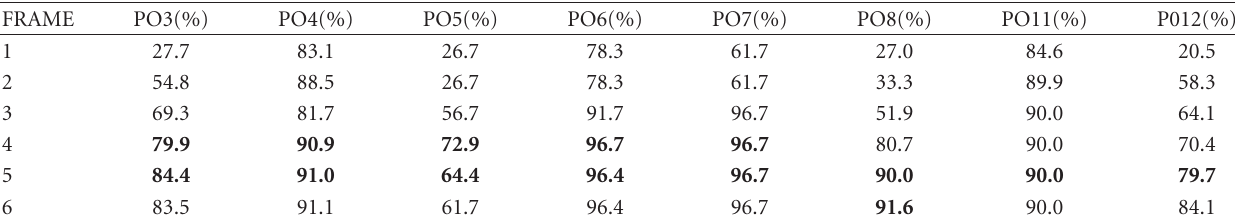
Table 7: The % FLPE crisp values of the six frames for Figure